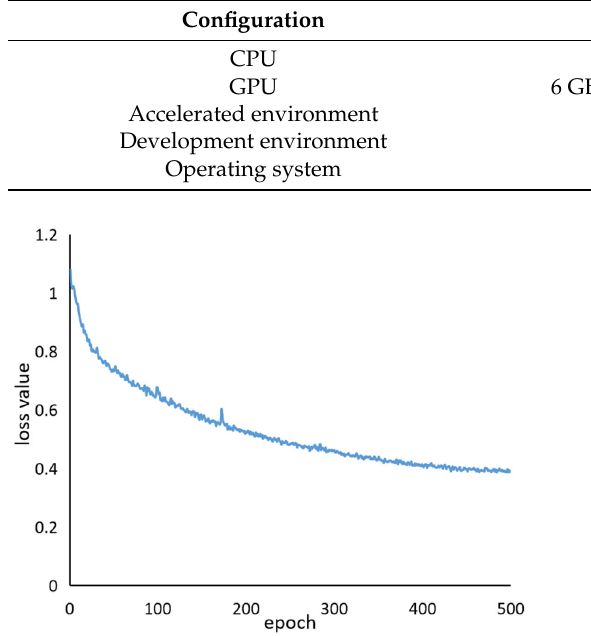
Table 1. Experimental Environment.